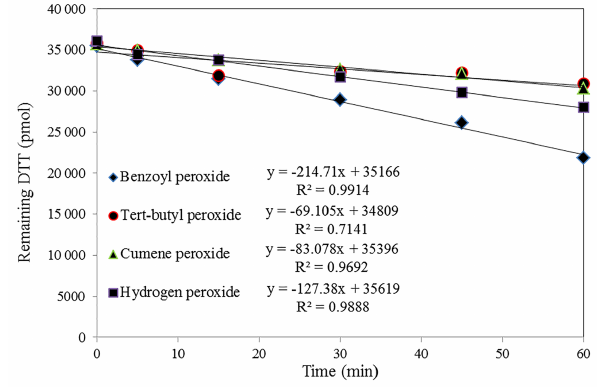
Figure 3. DTT activity of various types of peroxides (hydrogen peroxide, cumene peroxide, tert -butyl peroxide, benzoyl peroxide). With the same initial concentration of peroxide (120µM), ben- zoyl peroxide has the highest DTT activity (converted to DTT m of 37pmolmin − 1 µg − 1 )